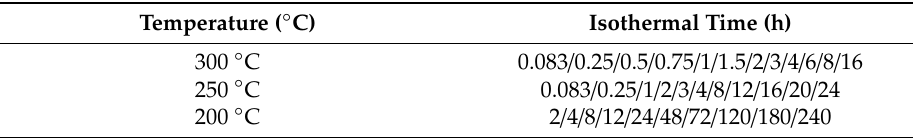
Table 3. Heat treatment parameters for isothermal